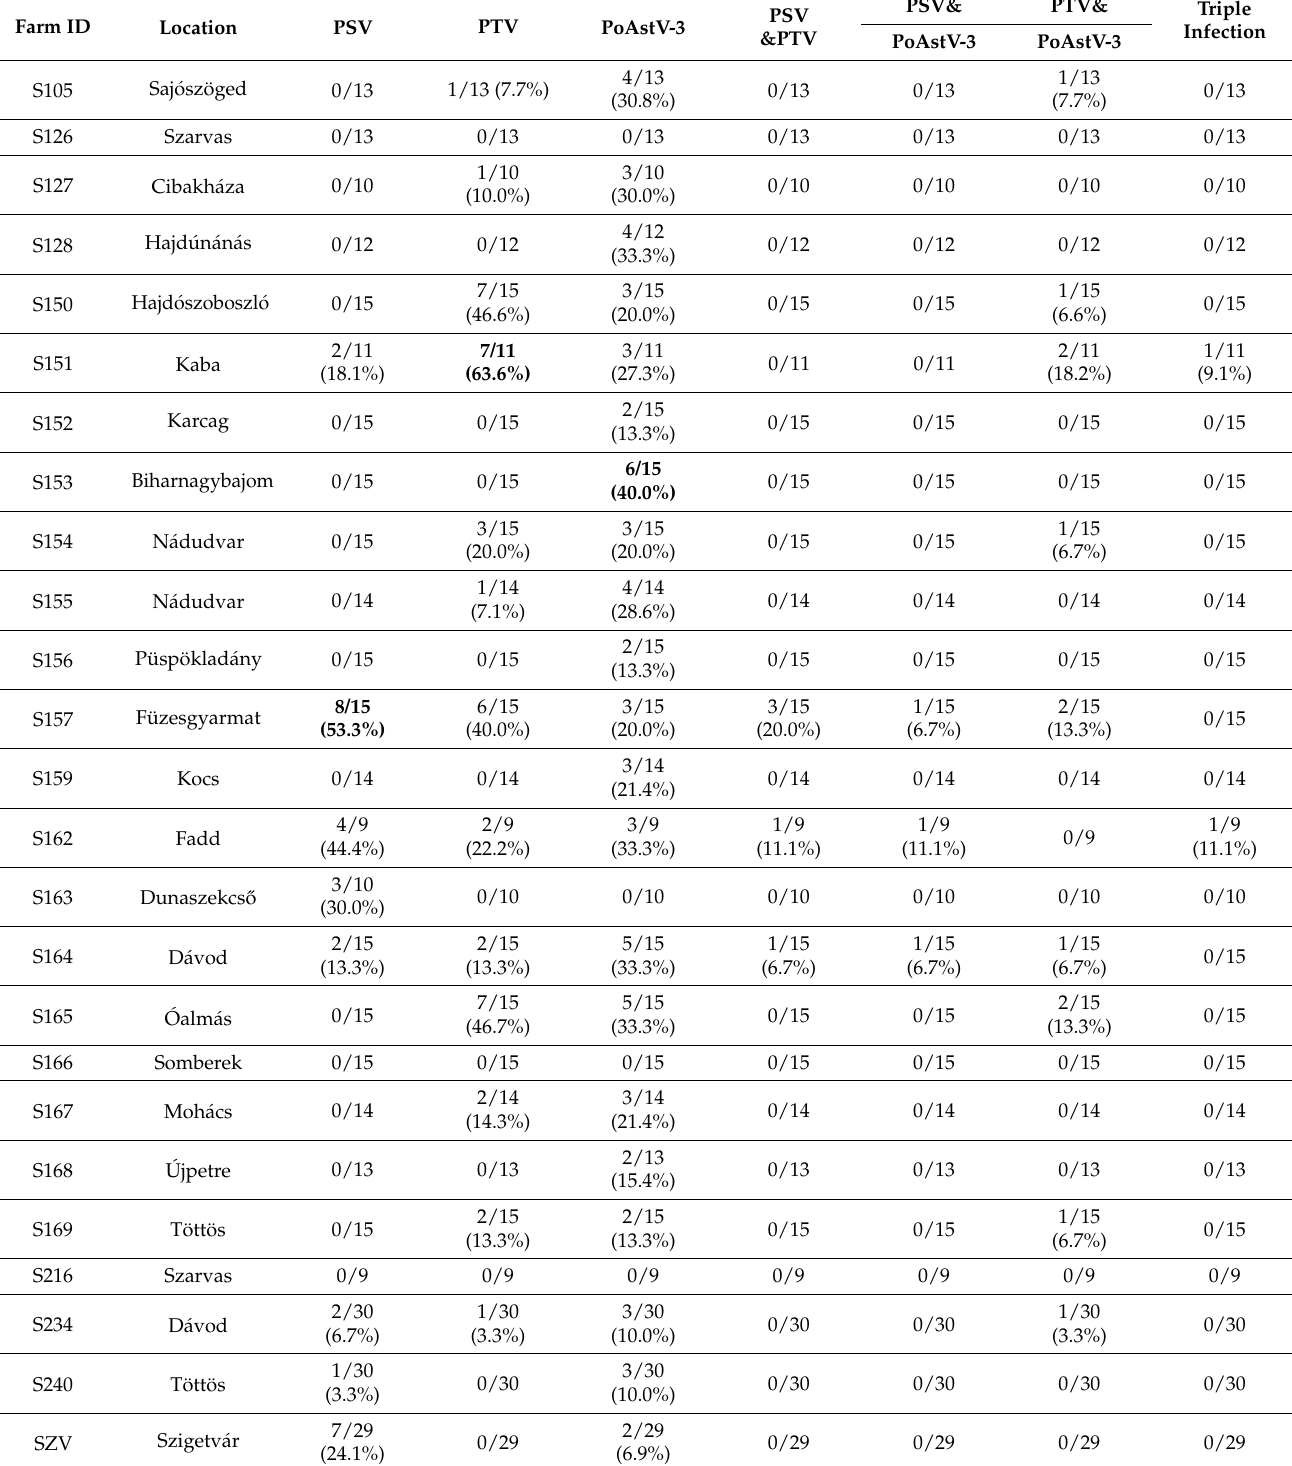
Table 5. Positivity rates (no. of positive/no. of tested with percentages) of porcine sapelovirus (PSV), porcine teschovirus (PTV) and porcine astrovirus type 3 (PoAstV-3), including double and triple infections identified by RT-qPCR in n = 473 nasal swab samples of n = 28 different Hungarian swine farms. The highest prevalence values of PSV, PTV or PoAstV-3 are marked in bold. For detailed RT-qPCR results, see Table